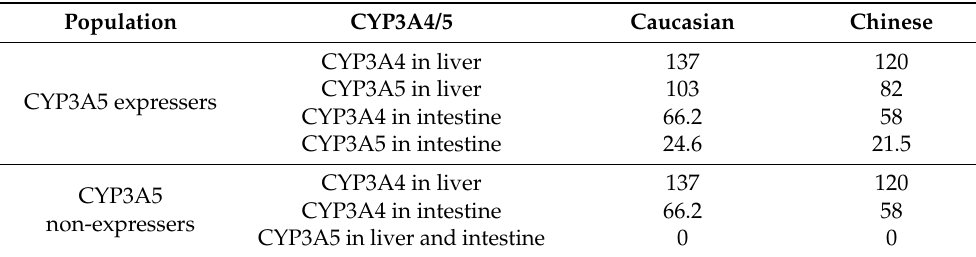
Table 4. CYP3A4 and CYP3A5 abundance in two virtual genotype